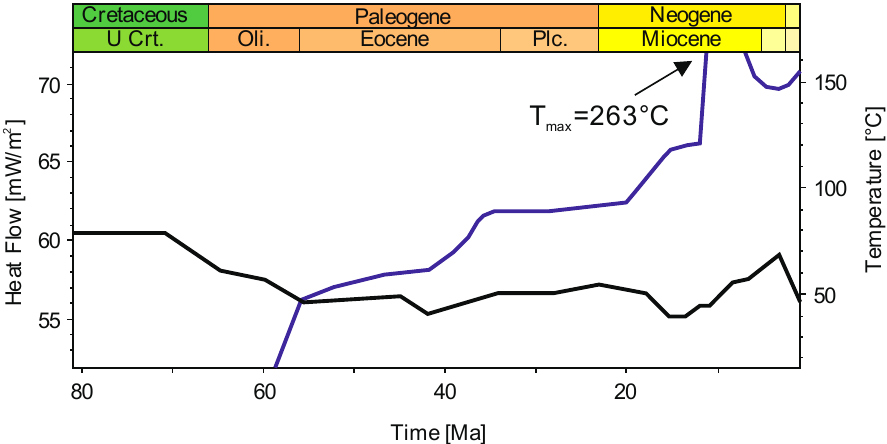
Figure 5. Input data for basal heat flow (black line) and temperature evolution for Waipawa layer (blue line), taking magmatic intrusion at 11 Ma into account.